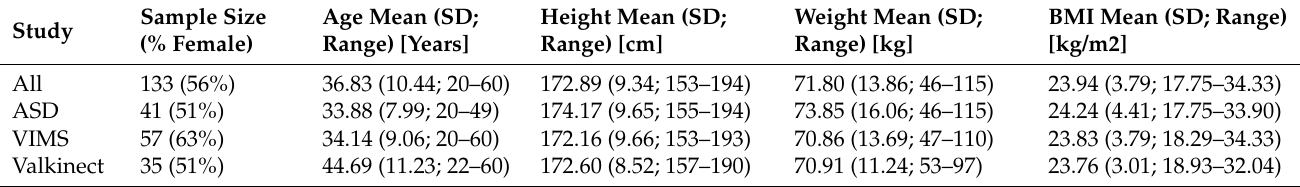
Table 1. Anthropometric and demographic subject characteristics overall and subdivided by study. Abbreviations: SD: standard